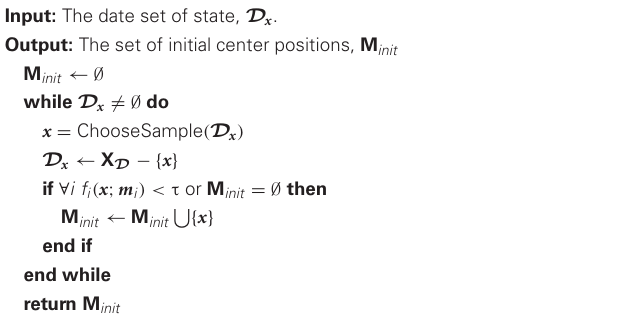
Procedure 1 | Setting initial position of the centers of the basis functions, M init